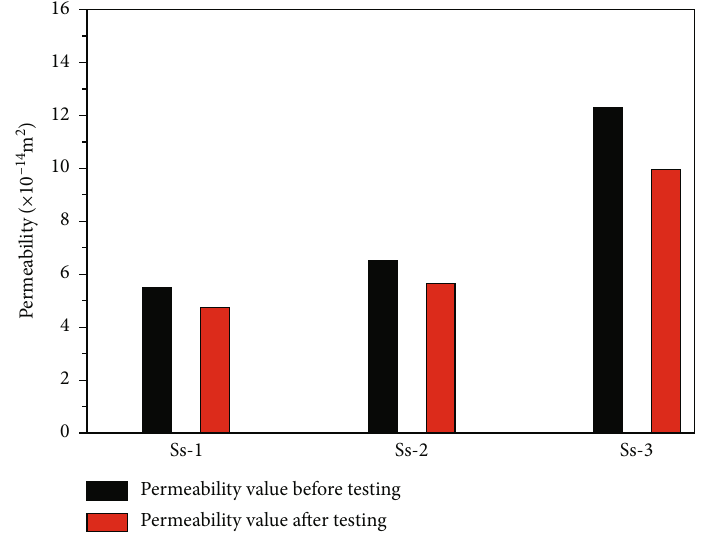
Figure 9: Permeability changes before and after testing under axial state stress.